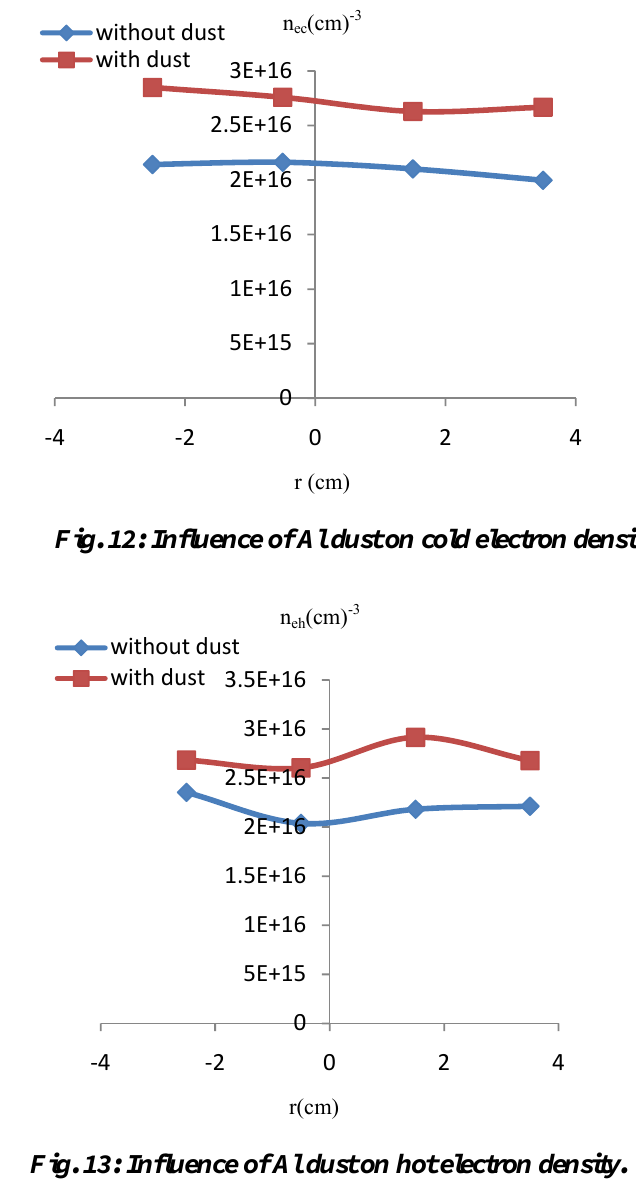
Fig. 13: Influence of Al dust on hot electron